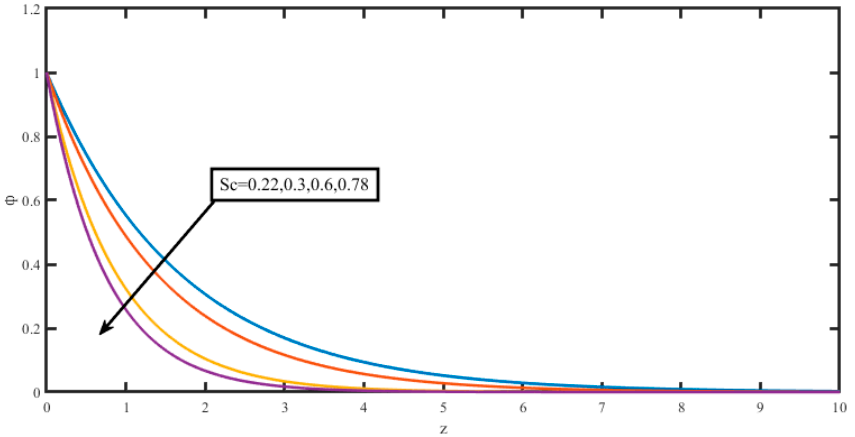
Figure 15. The influence of the Schmidt number Sc on the Concentration profiles.